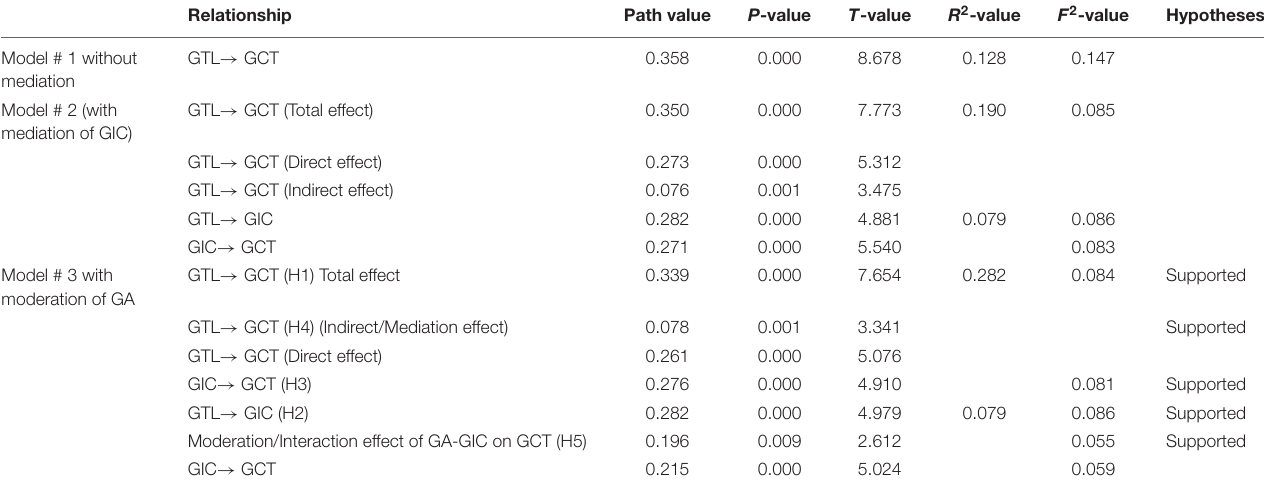
TABLE 3 | Structural model analysis and hypotheses testing.